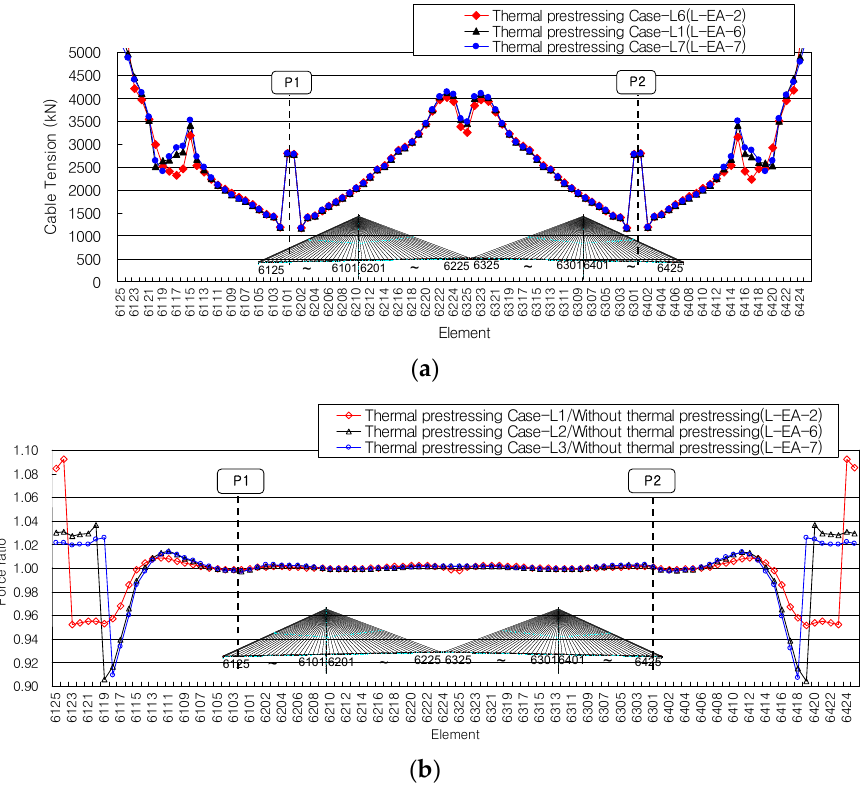
Figure 19. Cable forces with various numbers of earth-anchored cables. ( a ) Cable forces after completed construction; ( b ) Cable force ratio.